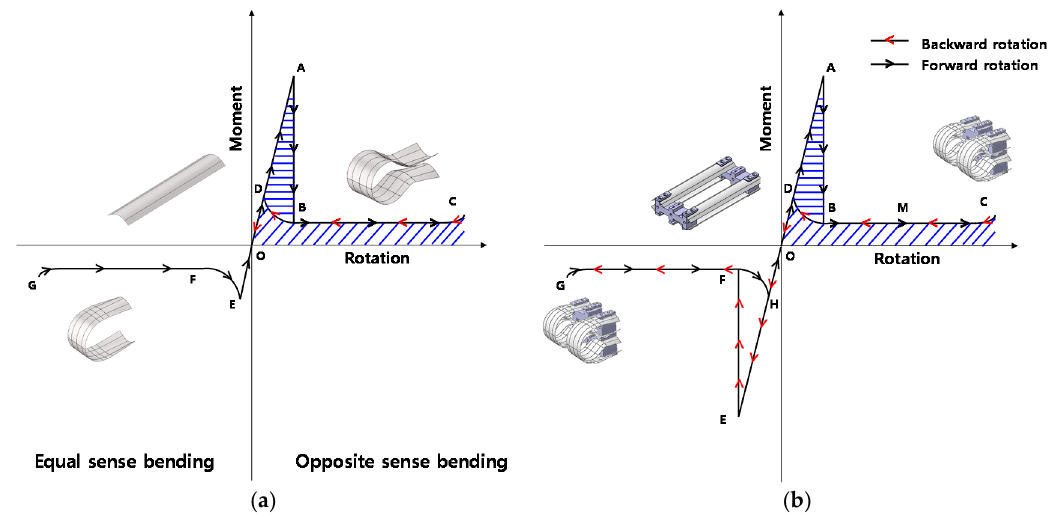
Figure 2. Typical moment–rotation profile of TS hinges: ( a ) single TS, ( b ) multi-layer TS.